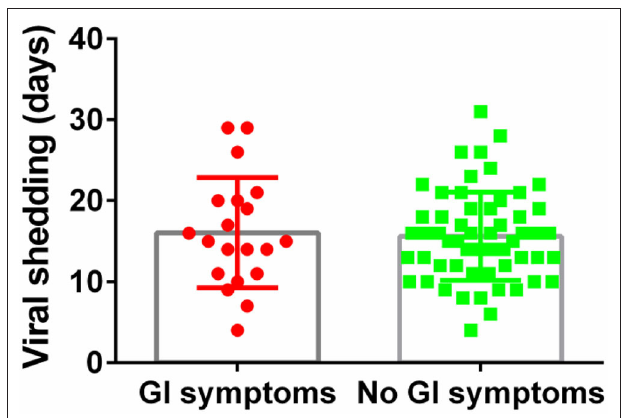
FIGURE 3 | Viral shedding days between patients with and without GI symptoms.